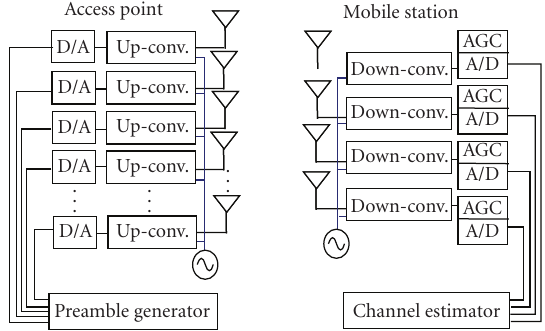
Figure 3: Block diagram of the MIMO testbed.